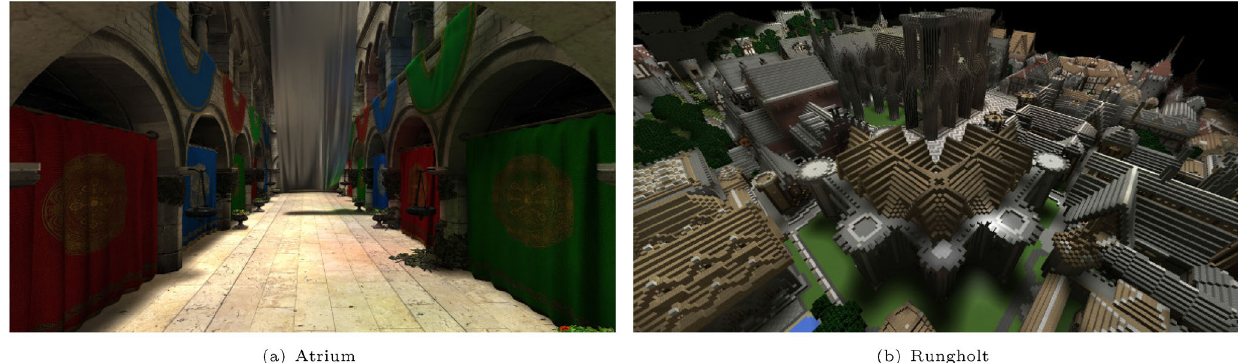
Fig. 1 Indirect lighting using VPLs with a small indoor Atrium scene and large outdoor Rungholt